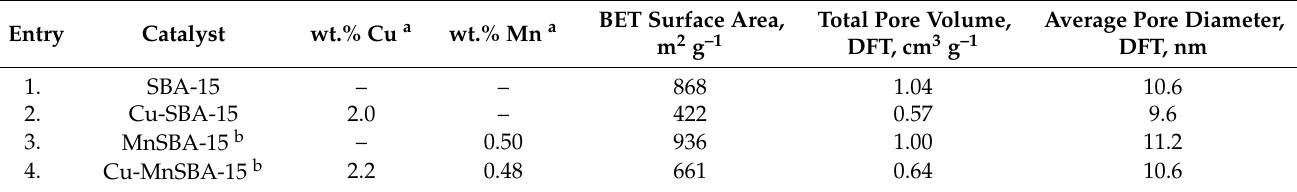
Table 1. The chemical composition and textural properties of the